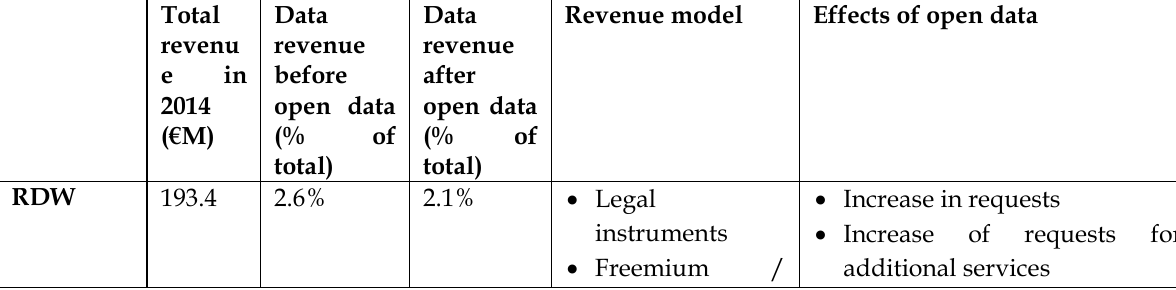
Table 3: Summary financial components of case